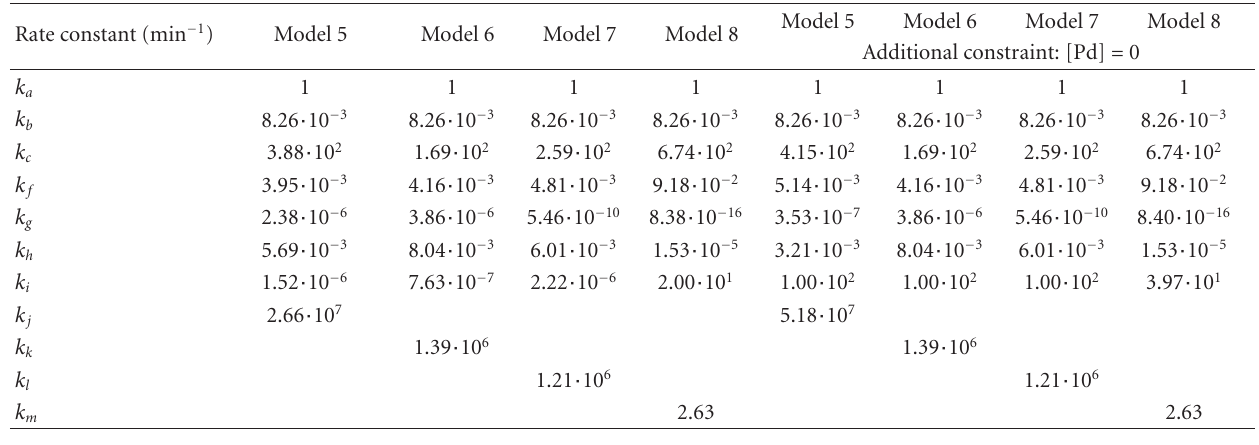
Table 3: Rate constants (Models 5–8) estimated using BatchCad kinetic fitting package.